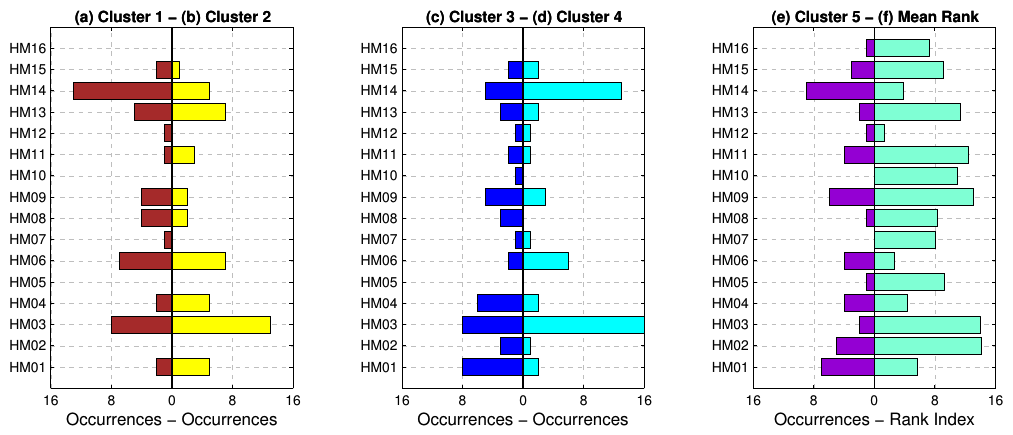
Fig. 7. Hydrological Models participation. Distribution in the five regions (clusters) are presented in (a) – (e) . Model performance evaluated as the mean rank index is shown in (f)